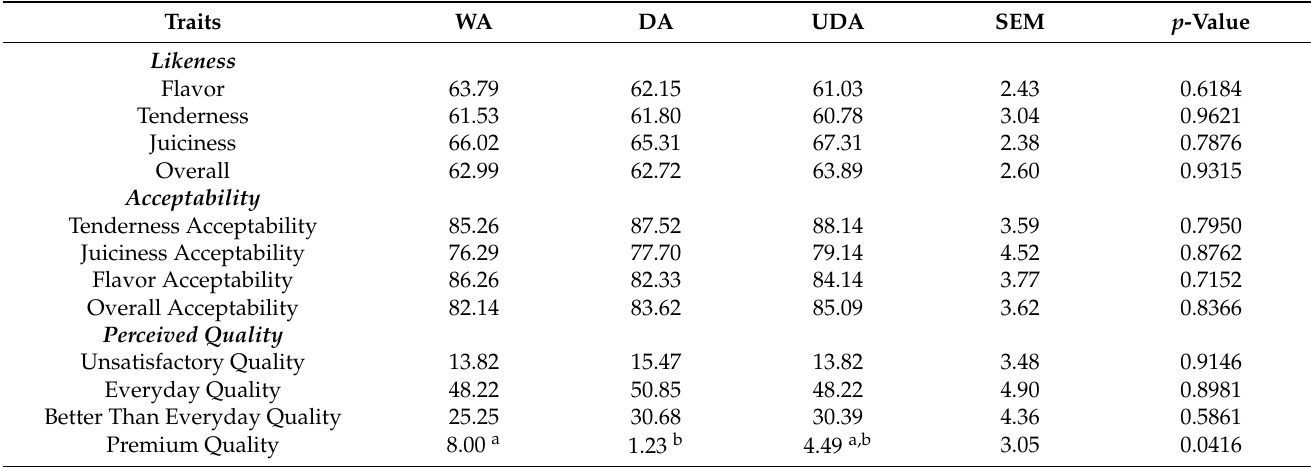
Table 5. Effect of different aging treatments on consumer sensory panel ( n = 120) for likeness, acceptability, and perceived quality of pork loins ( M. Longissimus lumborum ) aged for 21